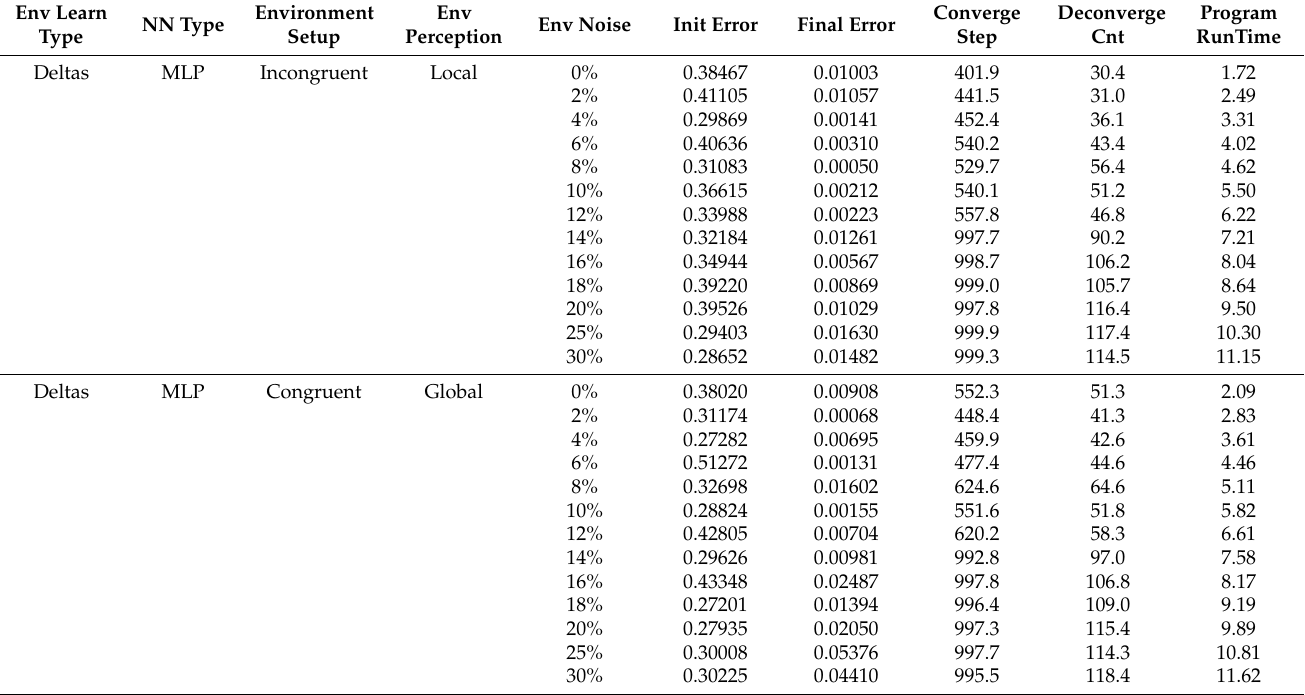
Table 6. Environmental Noise